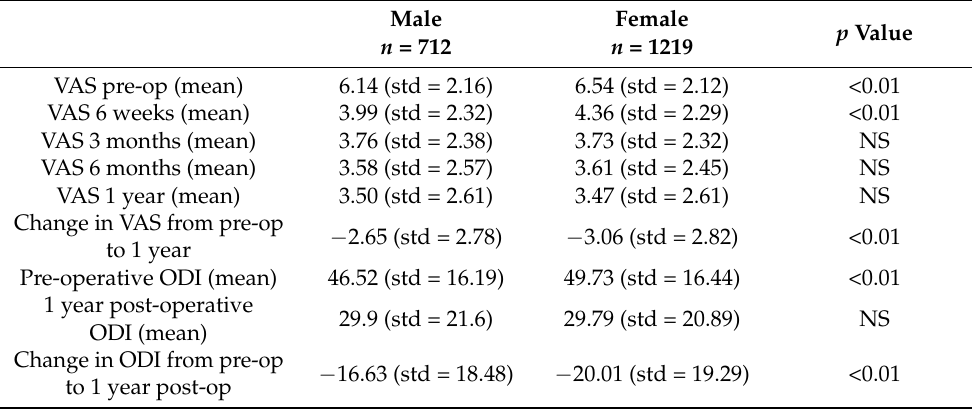
Table 4. Visual Analog Scale (VAS) for pain pre-operatively and at 6 weeks, 3 months, 6 months, and 1 year post-operatively, separated by gender. Oswestry Disability Index (ODI) score pre-operatively and post-operatively at 1 year, separated by gender.